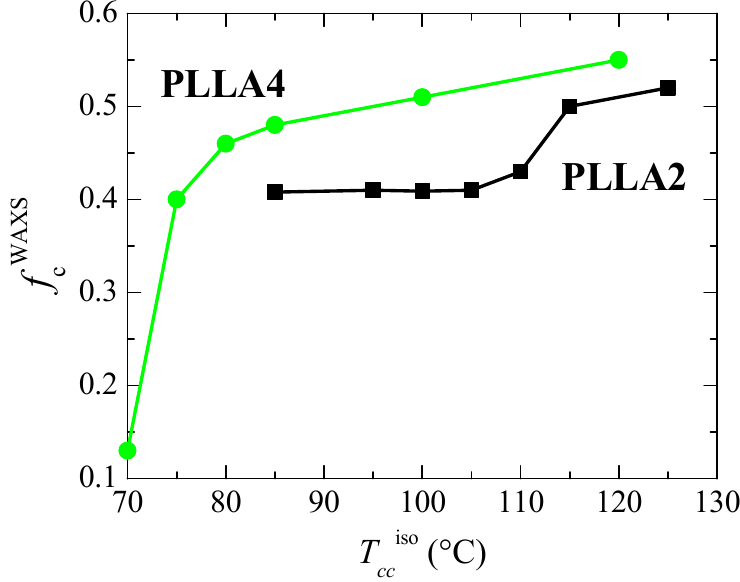
Figure 9. Dependence on crystallization temperature, T cc iso , of the degree of crystallinity determined by WAXS for the neat PLLAs studied.